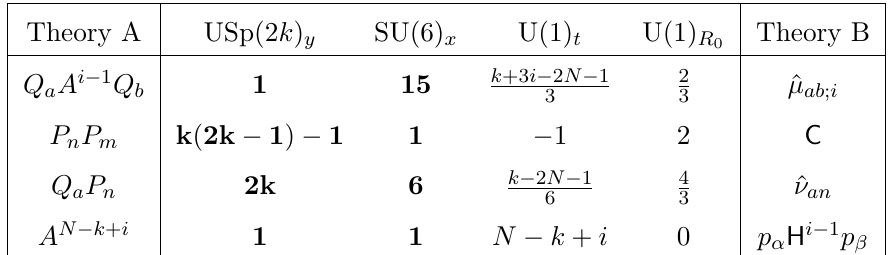
the same charges under U(1)